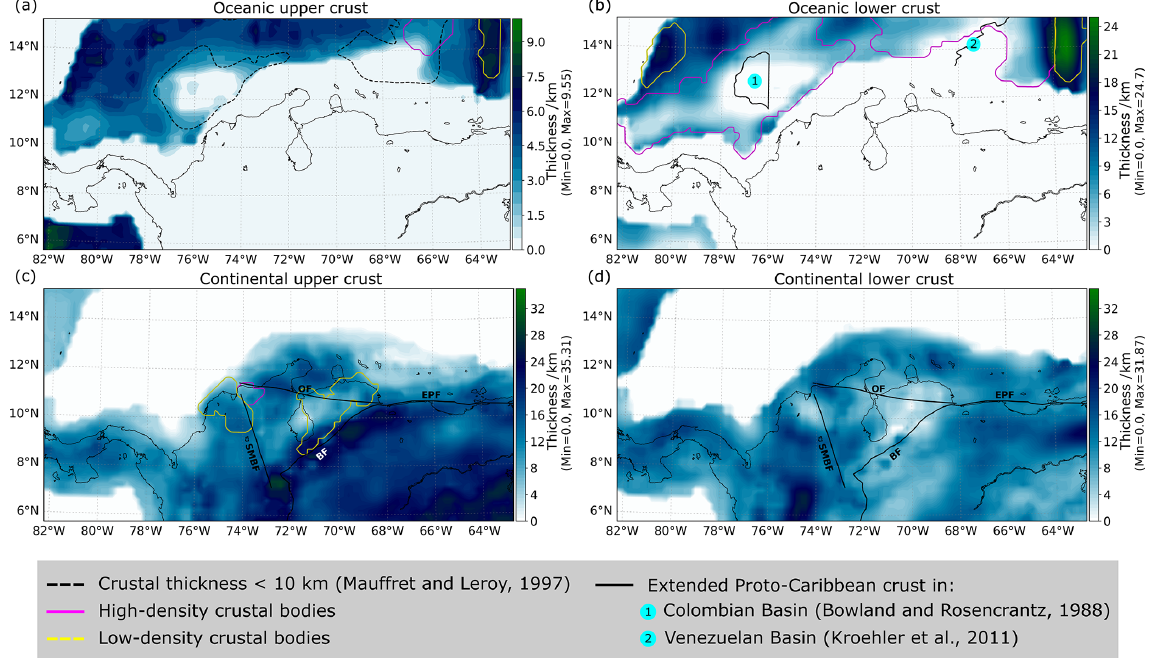
Figure 8. Thickness of the (a) oceanic upper crust, (b) oceanic lower crust, (c) continental upper crust, and (d) continental lower crust. Dashed polygons in (a) represent places where the oceanic crust is thinner than 10km (Mauffret and Leroy, 1997). Black polygons in (b) depict areas with smooth basement (B (cid:48)(cid:48) horizon), associated with extended Proto-Caribbean crust in the Colombian Basin (Bowland and Rosencrantz, 1988) (number 1) and in the Venezuelan Basin (Kroehler et al., 2011) (eastward of the black line, number 2). Main continental faults are shown as thick black lines in (c) and (d) . The final lithospheric model includes different high- and low-density bodies in the oceanic and continental crusts, depicted as magenta and yellow polygons, respectively. Acronyms are the same as in Fig. 1.